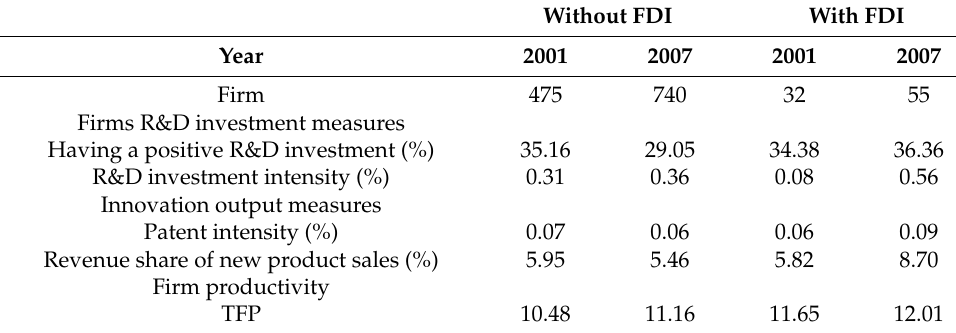
Table 4. Summary statistics of key variables among firms with and without